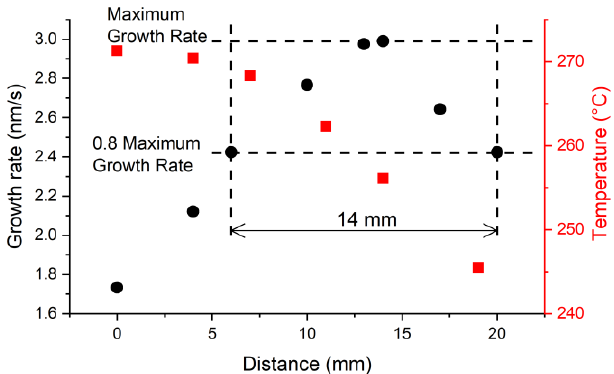
Figure 8. The temperatures inside the reactor (red squares) and the growth rate of the ZnTe film on the surface of the optical fiber (black circles) depending on the position of the thinned area of the light guide relative to the furnace center.